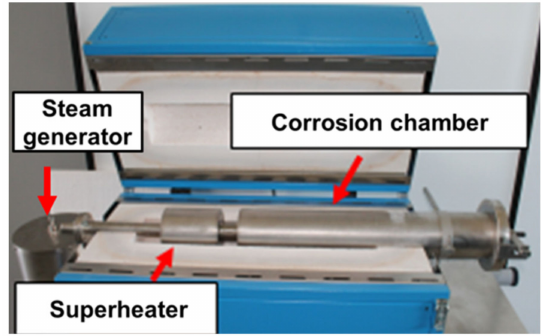
Figure 1. Corrosion furnace for isothermal oxidation test in steam atmosphere under atmo- spheric